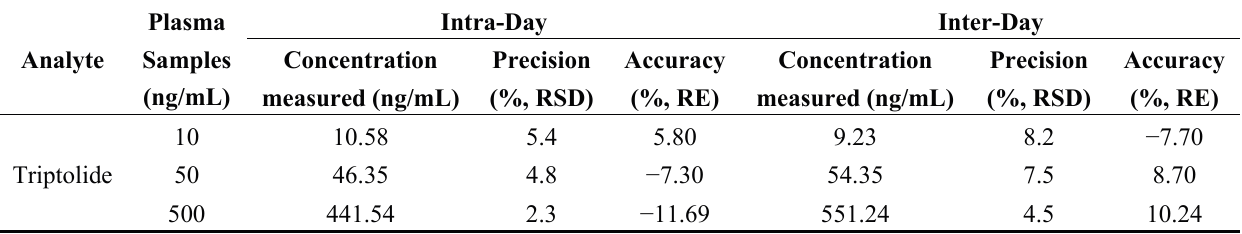
Table 1. The precision and accuracy of triptolide in plasma